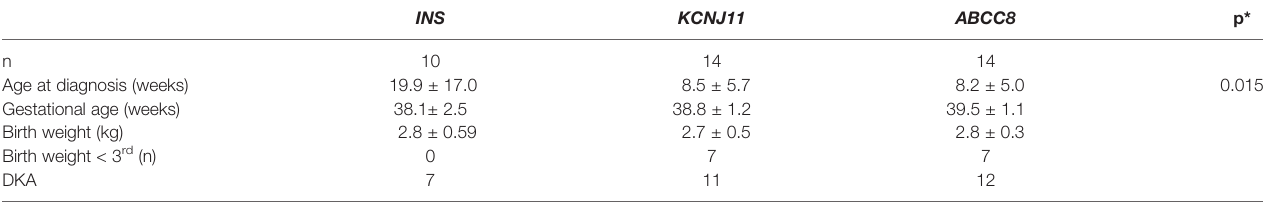
TABLE 2 | Comparison of clinical characteristics of children with diabetes caused by a mutation in INS , KCNJ11 , or ABCC8